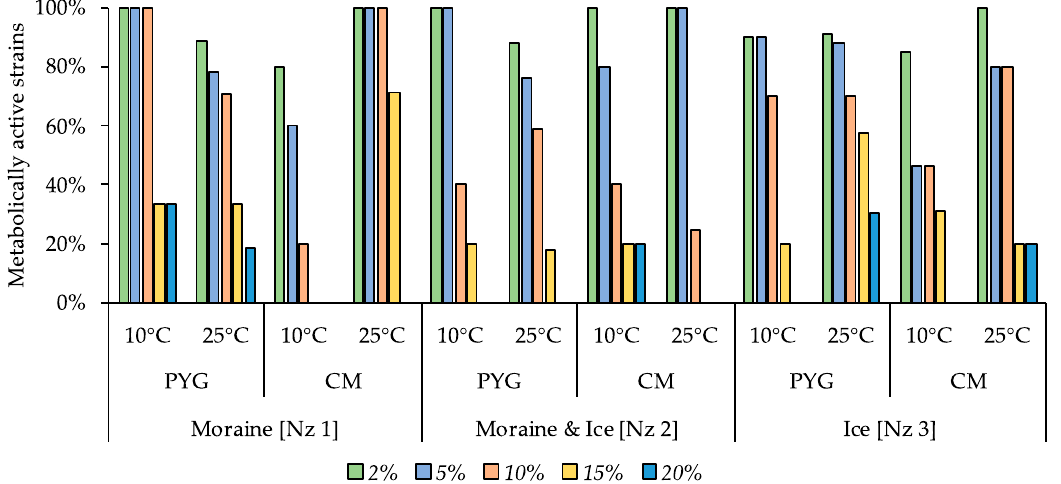
Figure 9. Isolated strains’ resistance to the presence of potassium chloride in nutrient medium. Vertical axis: proportion of the strains in the culturable community able to reproduce in the considered conditions. Horizontal axis: the tested communities. Temperature and medium abbreviations indicate the isolation conditions. PYG and CM—peptone yeast glucose and modified Czapek media, respectively.